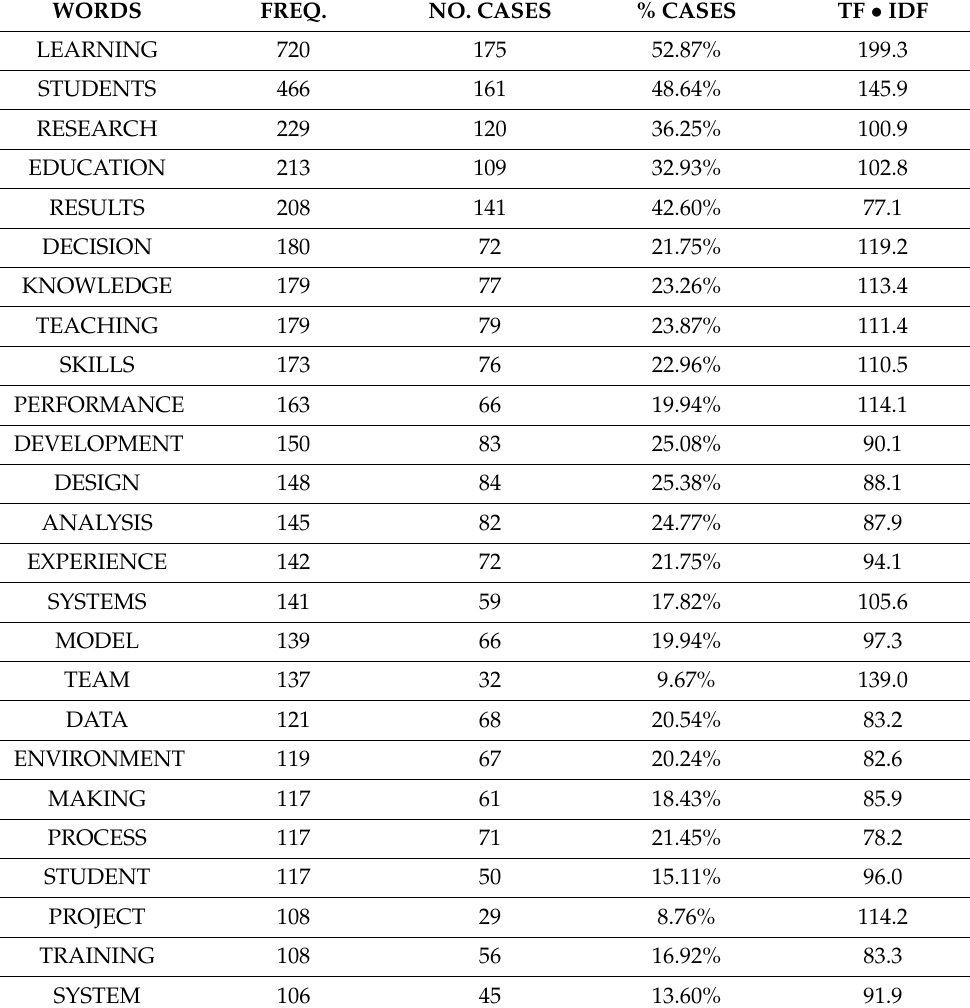
Table 5. Extracted words (100+